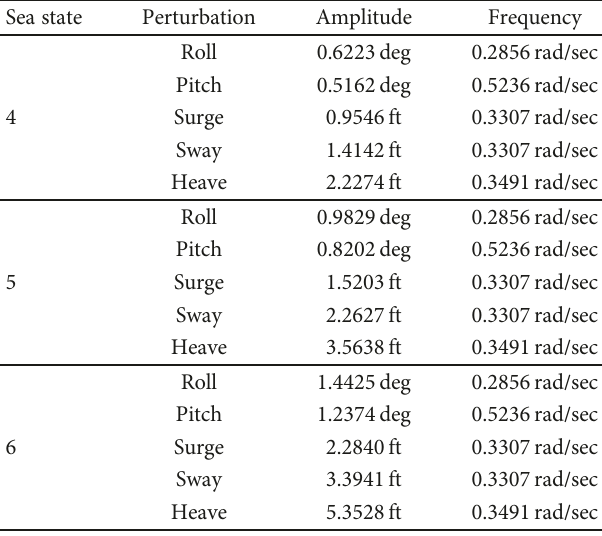
Table 2: Summary of sea state